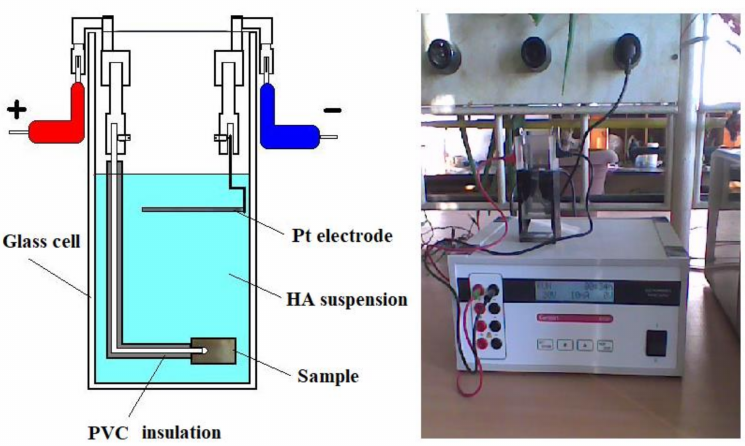
Figure 1. Deposition cell scheme and experimental set-up. During the process, a voltage of 75 V was applied between the anode (Ti4Al4Zr alloy, S = 3 cm 2 ) and cathode (platinum, S = 6 cm 2 ) for 15 min, with a distance of 20 mm between the electrodes. A suspension of 4 g HA powder (0.61 µ m average diameter) in 100 mL isopropyl alcohol, stabilized with 1 mL Tween 80 surfactant, was used in the process. After obtaining the growth film, the sample was washed with water, heated in a furnace at 110 ◦ C for 2 h, and calcinated at 800 ◦ C for 2